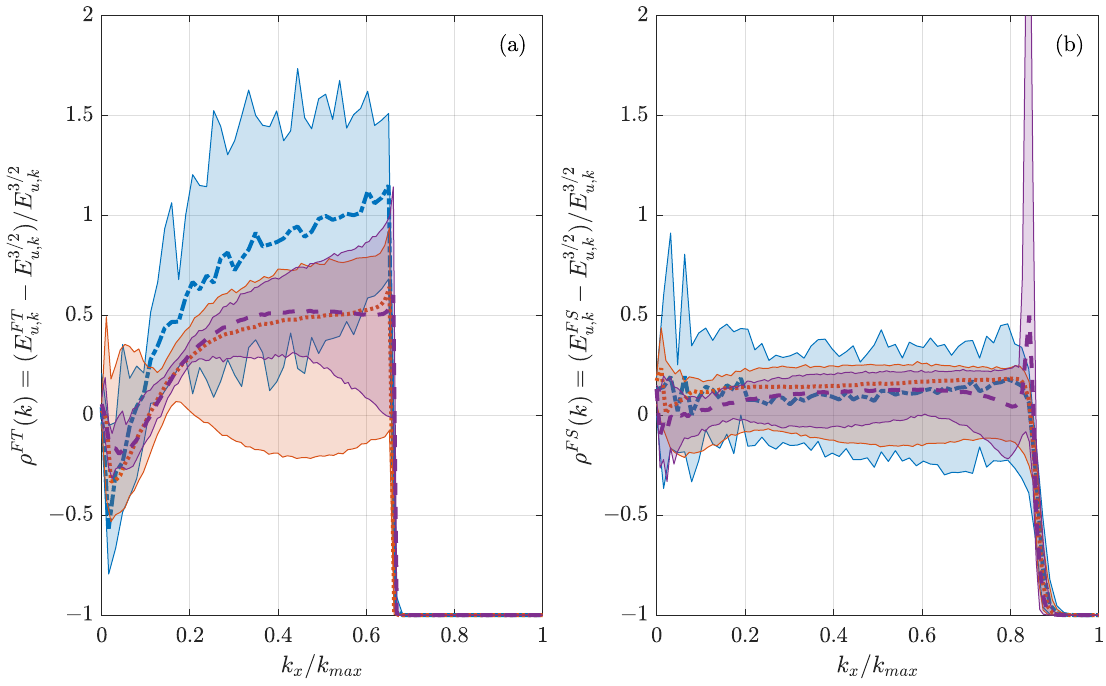
Figure 10. Effect of the FT (a) and the FS (b) methods of the streamwise spectra of the streamwise velocity compare to the 3 / 2 rule. The solid line represent the average value and the shaded area represent the extreme values. The resolutions are 128 3 as the blue dot–dashed line, 192 3 as the red dotted line, and 256 3 as the purple dashed